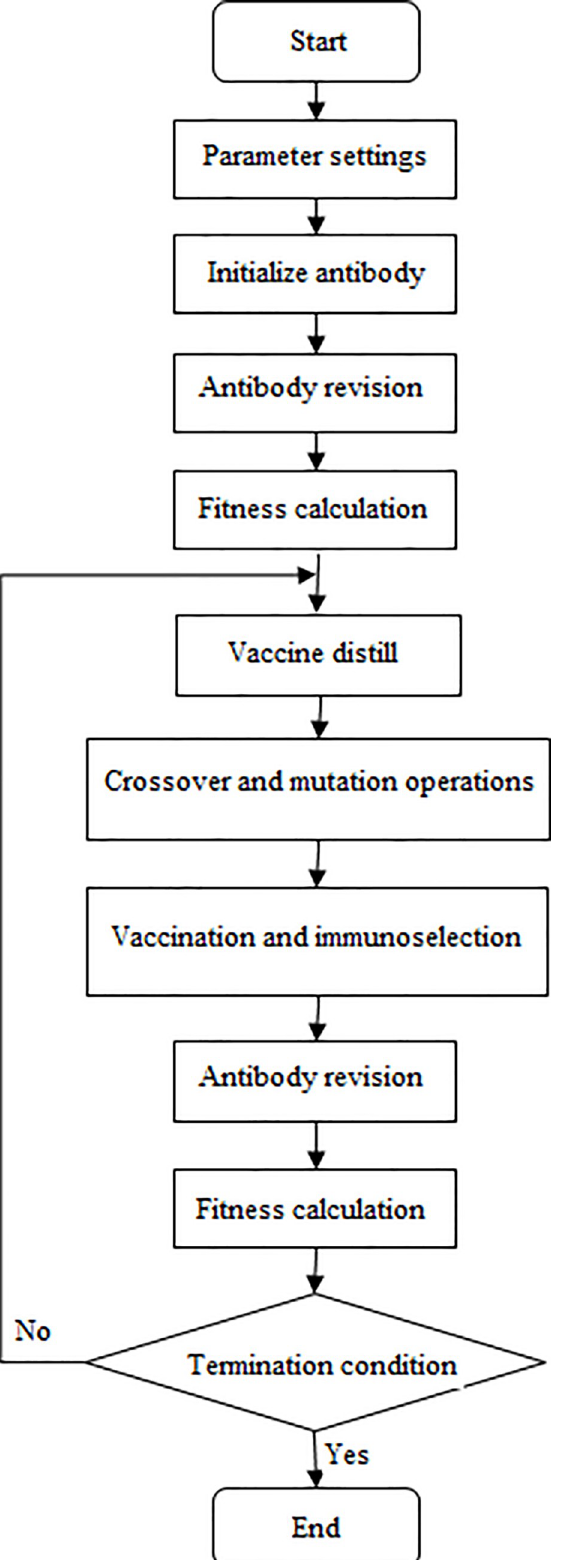
Fig 9. Flow chart of two-dimensional immune